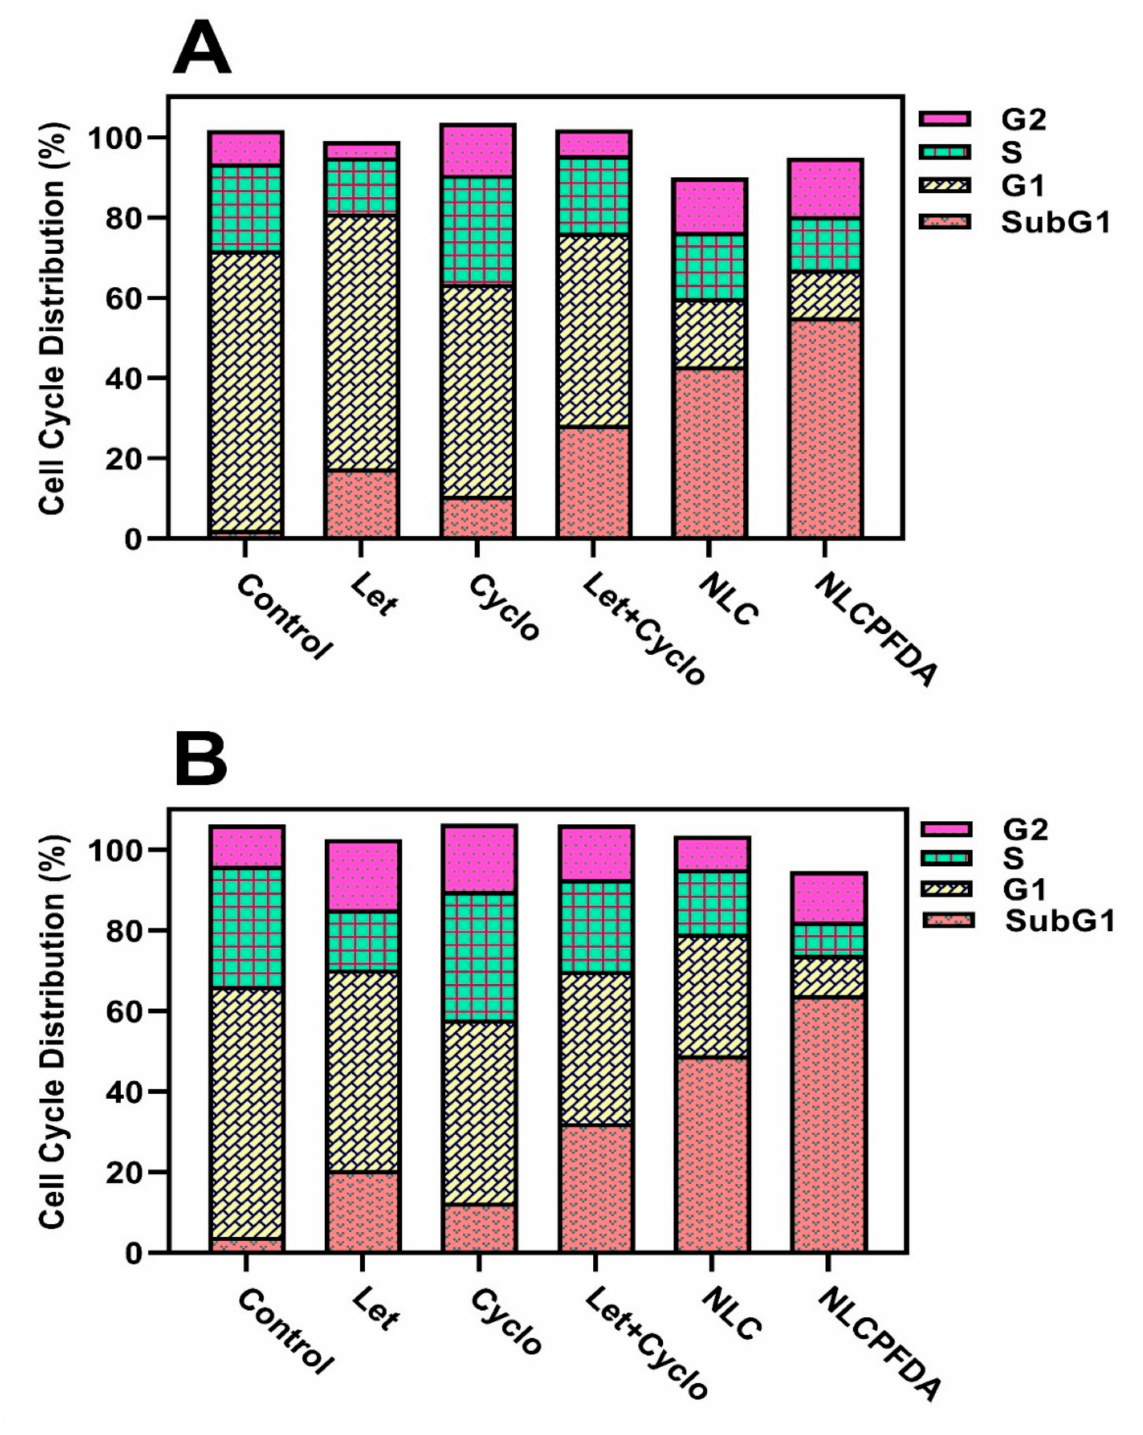
Figure 7. Cell cycle distribution for ( A ) MDA-MB-231 and ( B ) SKBR3 cancerous cell lines after treating by different niosomal formulations and free